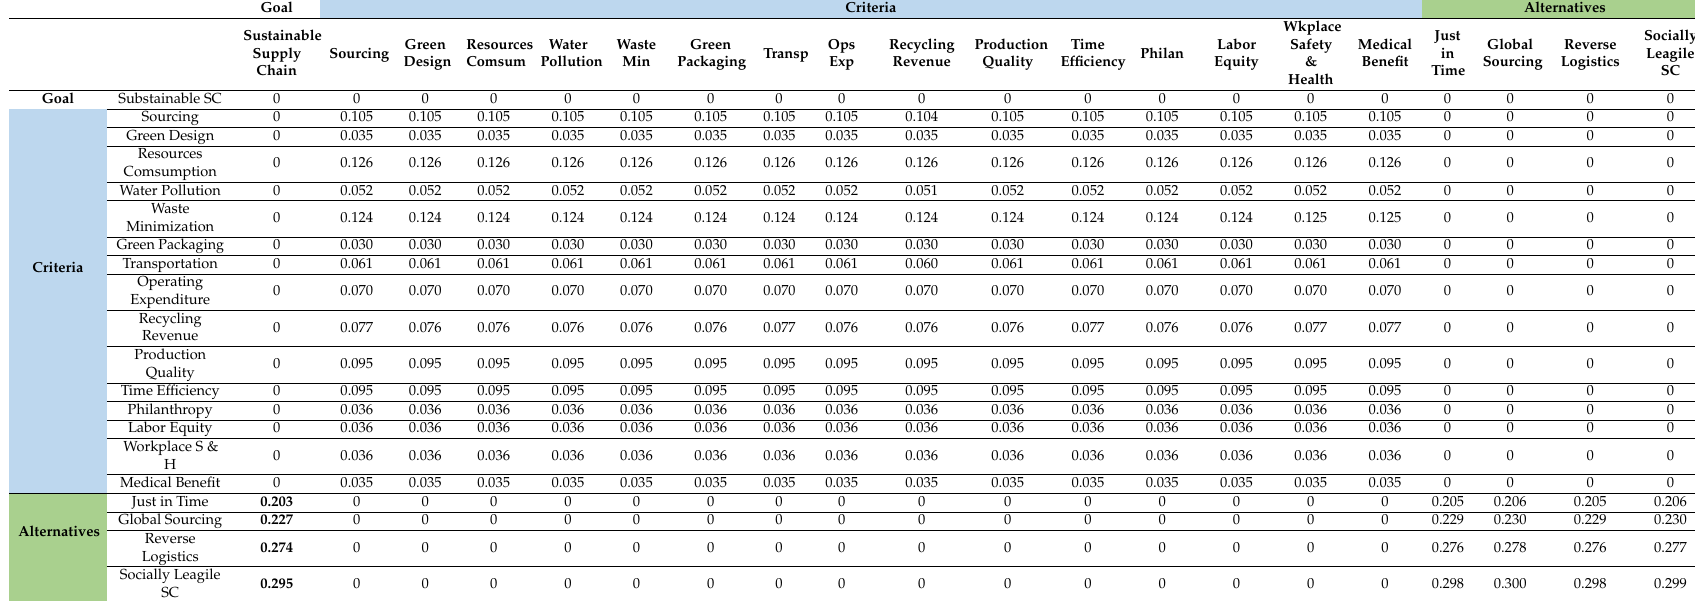
Table 16. The Limit Matrix of the ANP